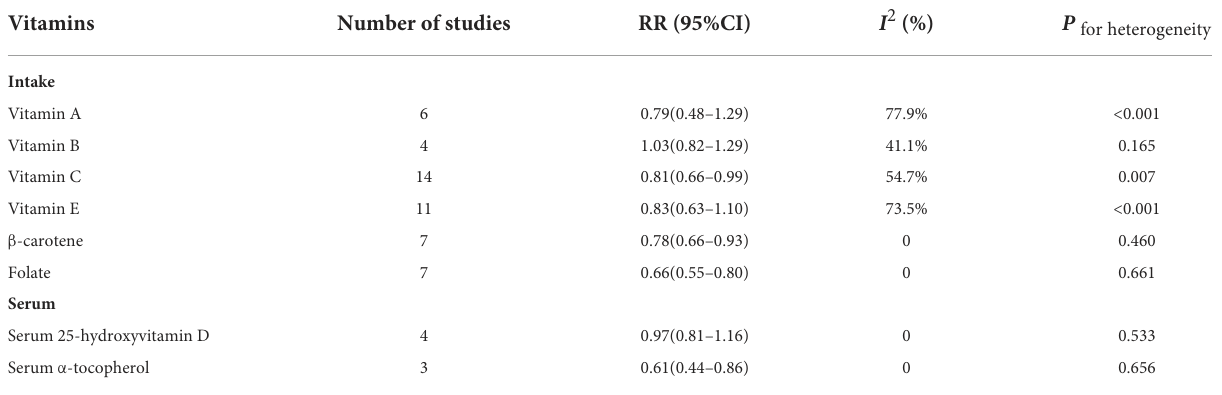
TABLE 2 A meta-analysis of the association between vitamins and brain